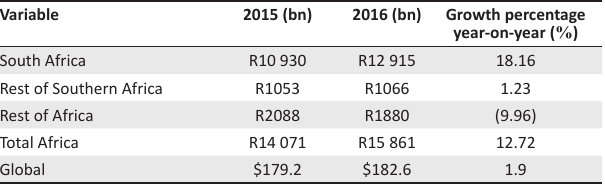
TABLE 1: Total size of the Direct Selling Association, in terms of the 2015 to 2016 total